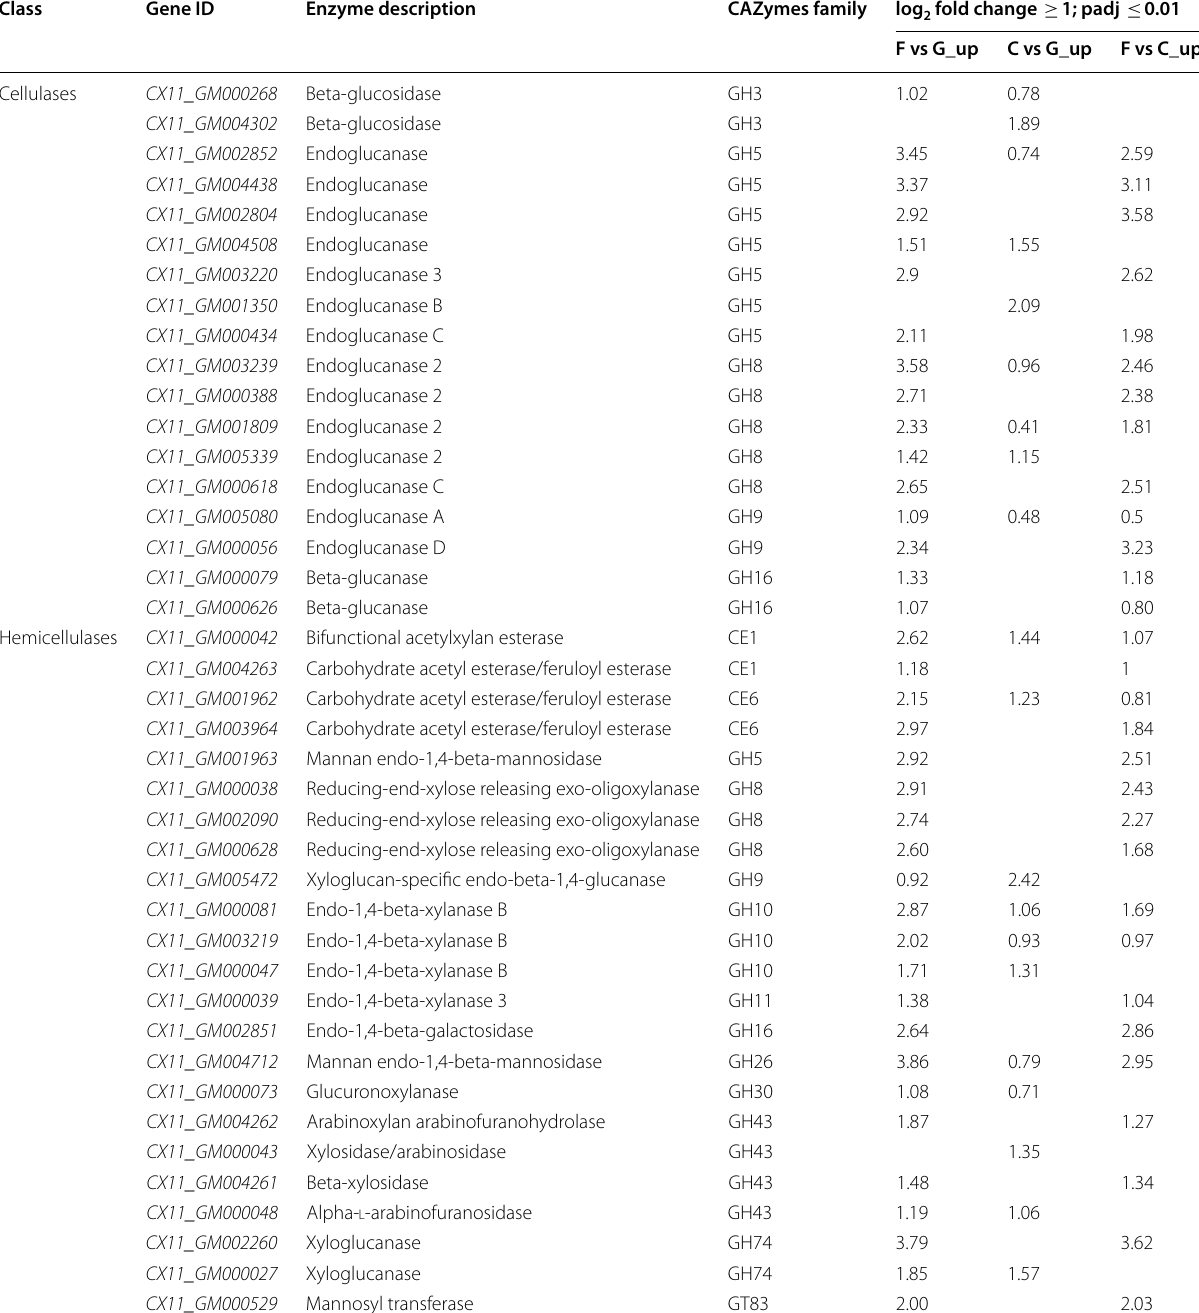
Table 1 Summary of CAZyme-encoding genes with significantly increased expression in groups Class